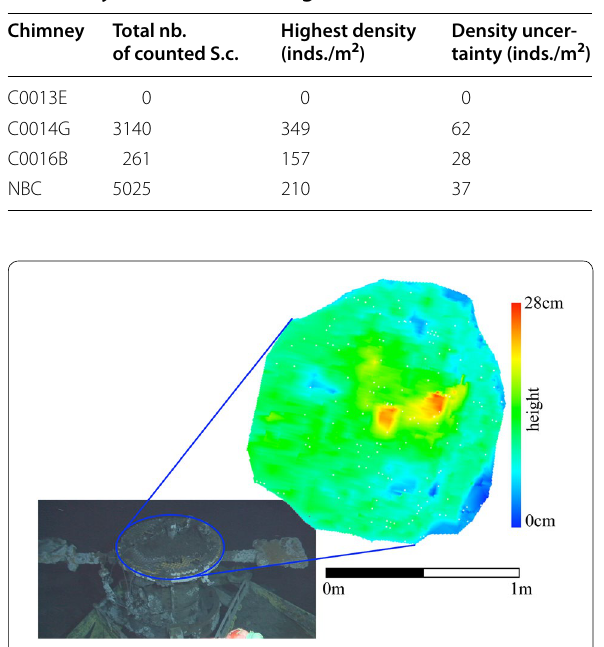
Fig. 13 Photo taken by ROV and depth map of chimney C0016B’s top plate with the remains of the hydrothermal